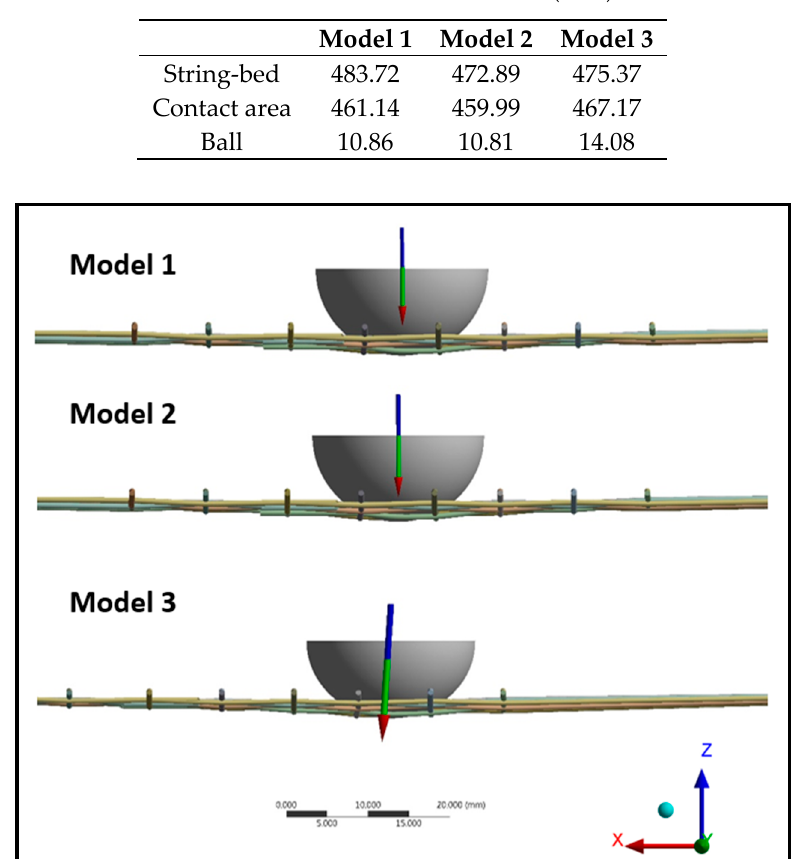
Table 1. Maximum von Mises stress (MPa).